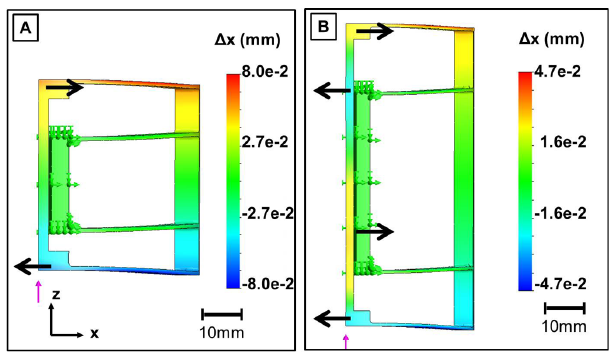
Figure 8. FEA of a curved compound-spring under a 10N load (A) No deformation of input stage (B) Deformed input stage as a result of the four-bar twist sti ff ness, K ψ , being larger than the stage sti ff